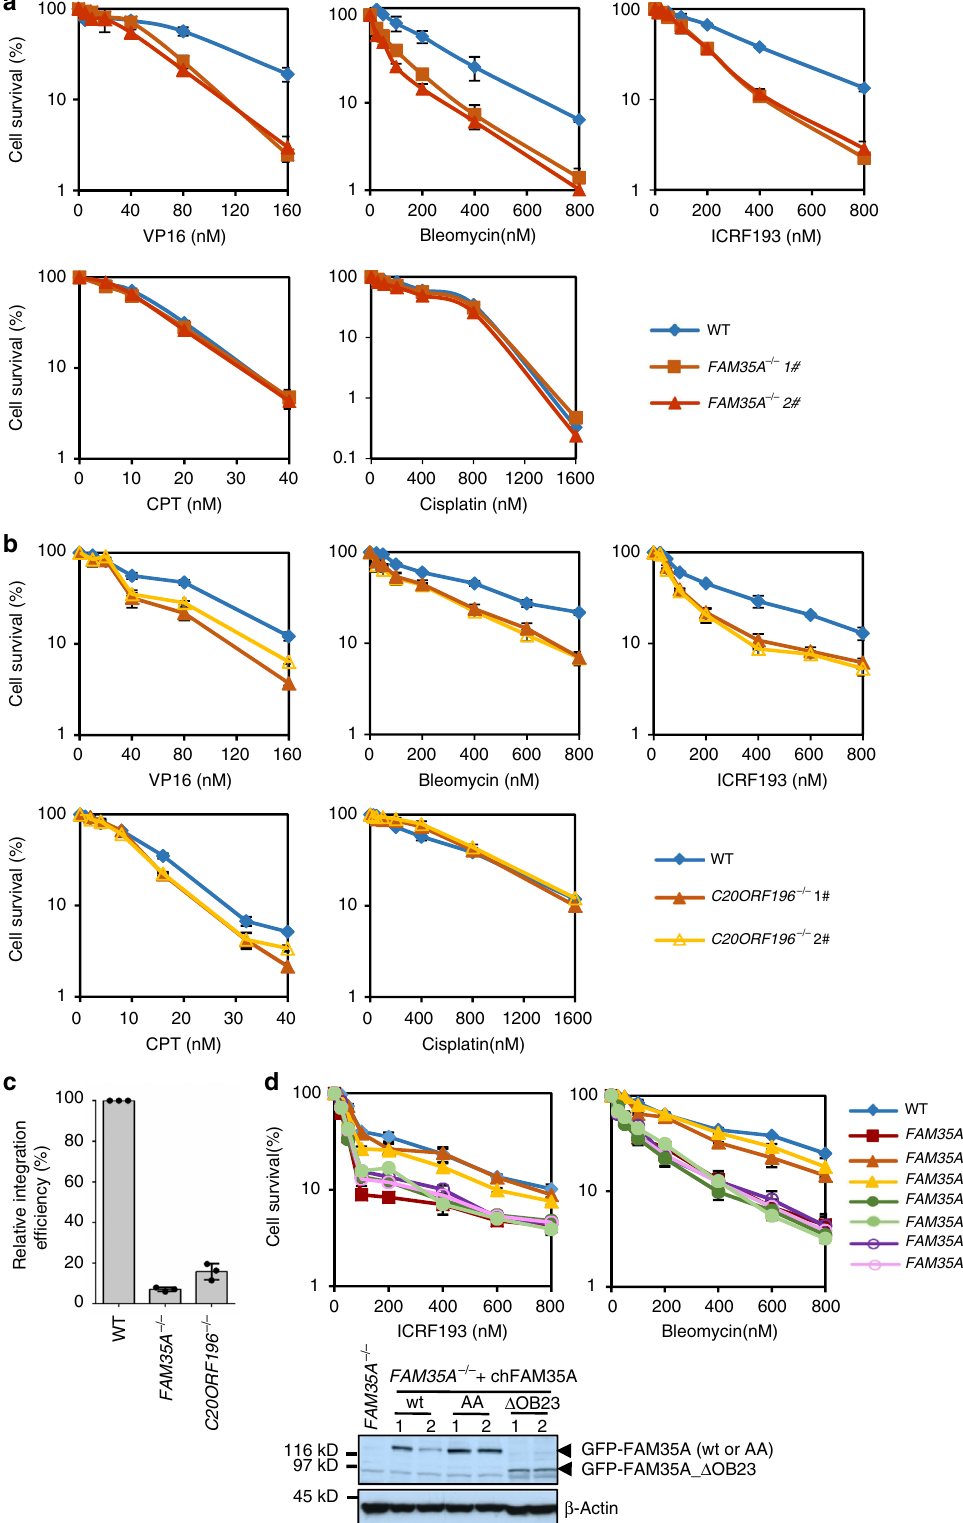
Fig. 3 FAM35A and C20ORF196 promote NHEJ to repair DSB. a , b Sensitivity assay of FAM35A ( a ) and C20ORF196 ( b ) knockout DT40 cells. The mean and s.d. from three independent experiments are shown. c Random integration assay of FAM35A and C20ORF196 knockout DT40 cells. Cells were transfected with the pLoxPuro plasmid and clonogenic potential was determined in the presence of puromycin. Data are expressed as the mean number of puromycin resistant colonies ± s.d. ( n = 3). d Sensitivity assay of FAM35A − / − cells re-expressing GFP-fused wild-type or mutated chicken FAM35A. Protein expression levels of GFP-chFAM35A were shown by immunoblotting on the